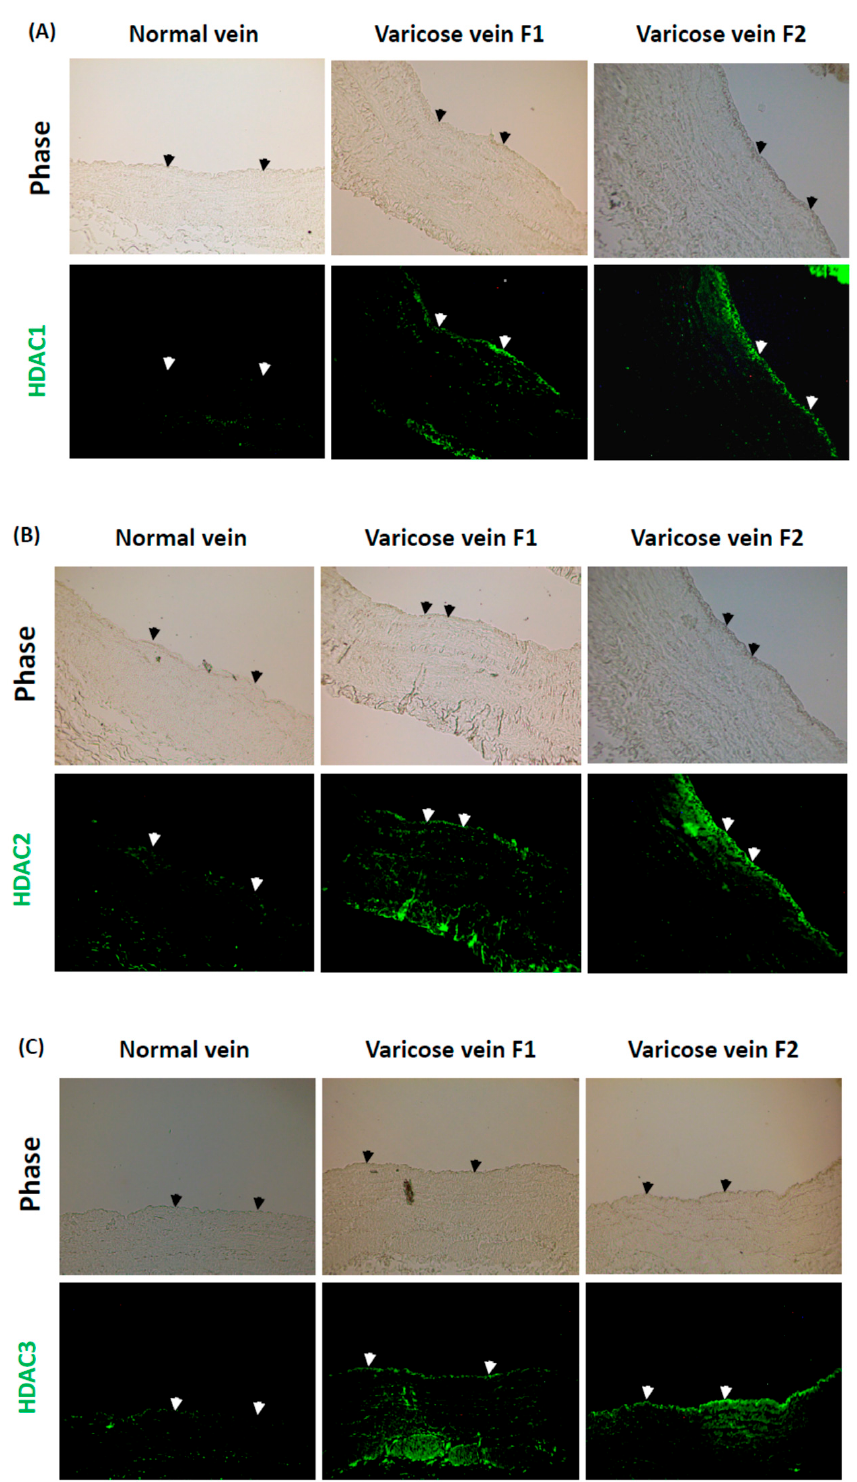
Figure 1. Class I histone deacetylases (HDACs) HDAC-1, -2, and -3 are predominantly expressed in the endothelium of human varicose veins with blood reflux but are rarely expressed in normal veins with normal venous flow. Cross-sections of human varicose veins with different levels of blood reflux (varicose vein F1 or F2) and human normal veins with normal venous flow (normal vein) were examined using immunostaining to detect the expression of human HDAC-1 ( A ), HDAC-2 ( B ), and HDAC-3 ( C ). Arrows represent the endothelia in the blood vessels. All photographs were obtained with fluorescence microscope with a 10× objective.